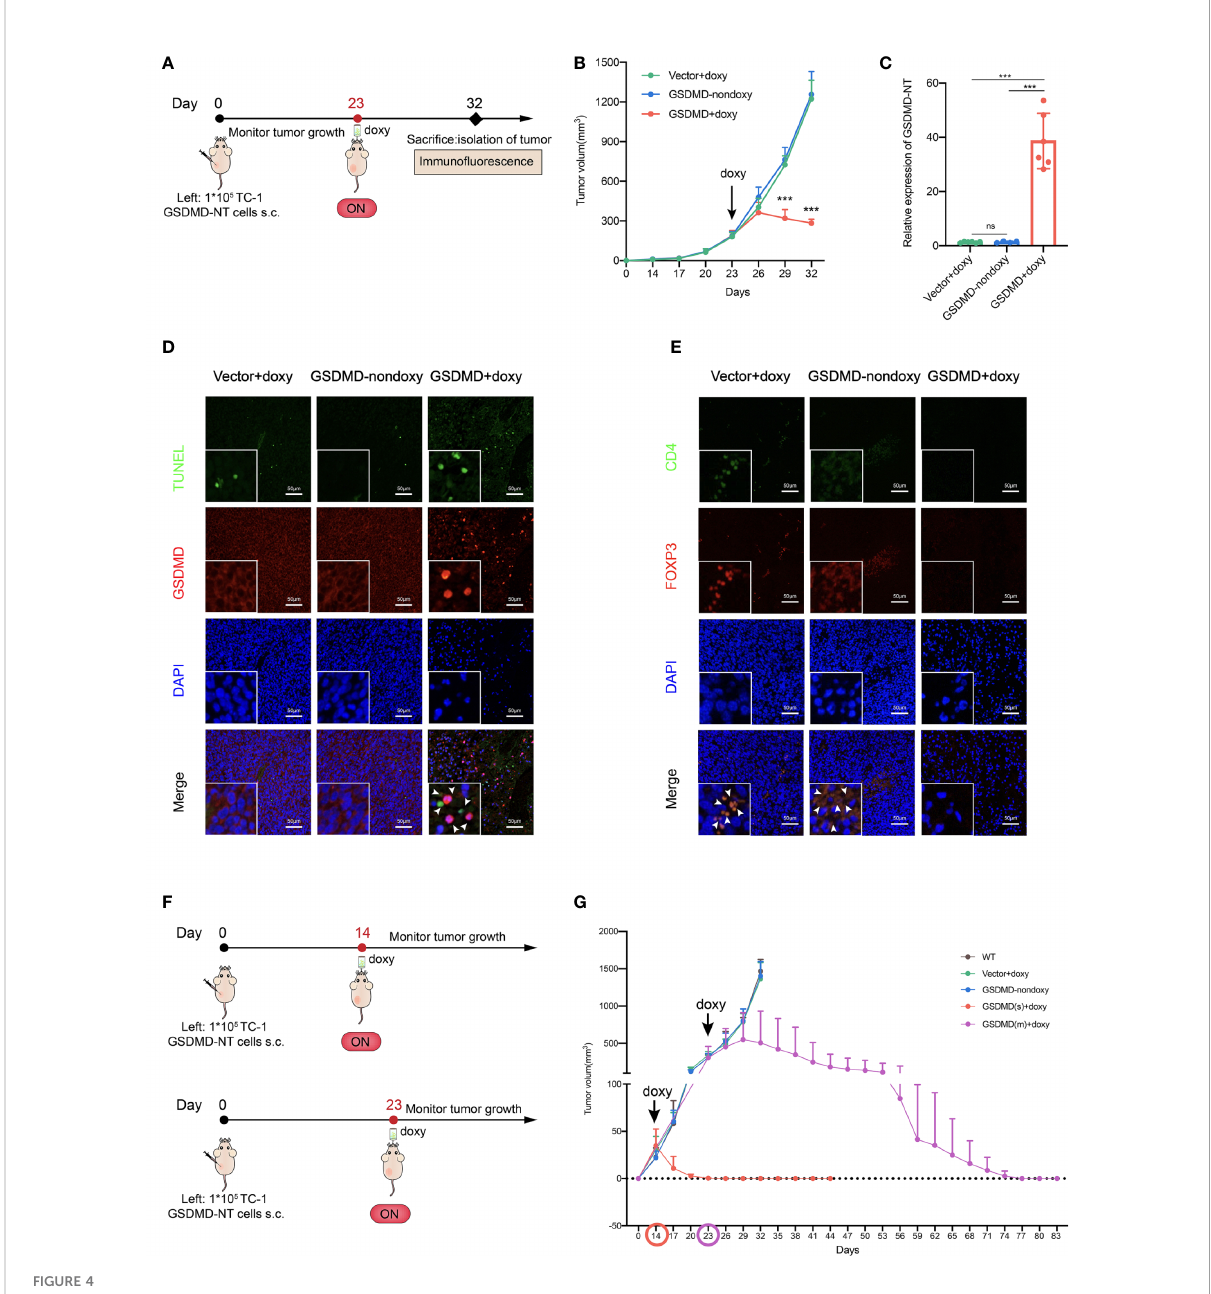
FIGURE 4 GSDMD-NT overexpression induces the complete clearance of the inoculated genetically modi fi ed tumor cells in mice. (A) The protocol for evaluating the growth of genetically inoculated tumors itself after inducing GSDMD-NT expression in a TC-1 tumor model. (B) The monitoring of tumor growth (n=3). (C) The expression of GSDMD-NT in the tumor tissues measured by RT-qPCR (n =6). On Day 32, the mice were sacri fi ced and the tumors were isolated. (D) TUNEL analysis (green) and immuno fl uorescence analysis of GSDMD-positive cells (red). DAPI was used for nuclear staining (blue). Scale bar, 50 m m. (E) Immuno fl uorescence analysis of tumor-in fi ltrating Tregs, using anti-CD4 and anti-Foxp3 antibody double staining represents Tregs, and DAPI was used for nuclear staining (blue). Scale bar, 50 m m. (F) The protocol for evaluating the potency of inducing GSDMD-NT-mediated pyroptosis, initializing the induction of GSDMD-NT expression at different tumor sizes. (G) The monitoring of tumor growth. GSDMD(s) and GSDMD(m) represent drinking doxy when the tumor volume reached to 20-50 mm 3 on Day 14 or 200-500mm 3 on Day 23, respectively (n=5). Graph shows means ± SD, (B) Two-way ANOVA; (C) One-way ANOVA; *** p value < 0.001, ns represents no signi fi